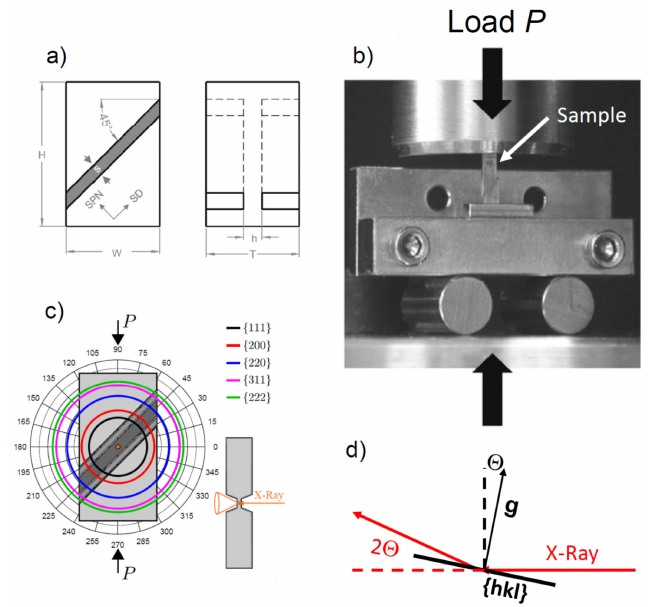
Figure 1. ( a ) Shear compression specimen in front and side view with dimensions marked; ( b ) experimental setup of shear compression; ( c ) sketch of a shear compression specimen (SCS) in front and side view serving as reference frame for obtaining polar plots. In all cases, the slit of the SCS is positioned 45 ◦ from the lower left to the upper right, and load is applied along the vertical direction. The smaller side view shows the trapezoid slit geometry. ( d ) Sketch explaining the deviation of the diffraction vector g from the position normal to synchrotron beam corresponding to an outer great circle in the pole